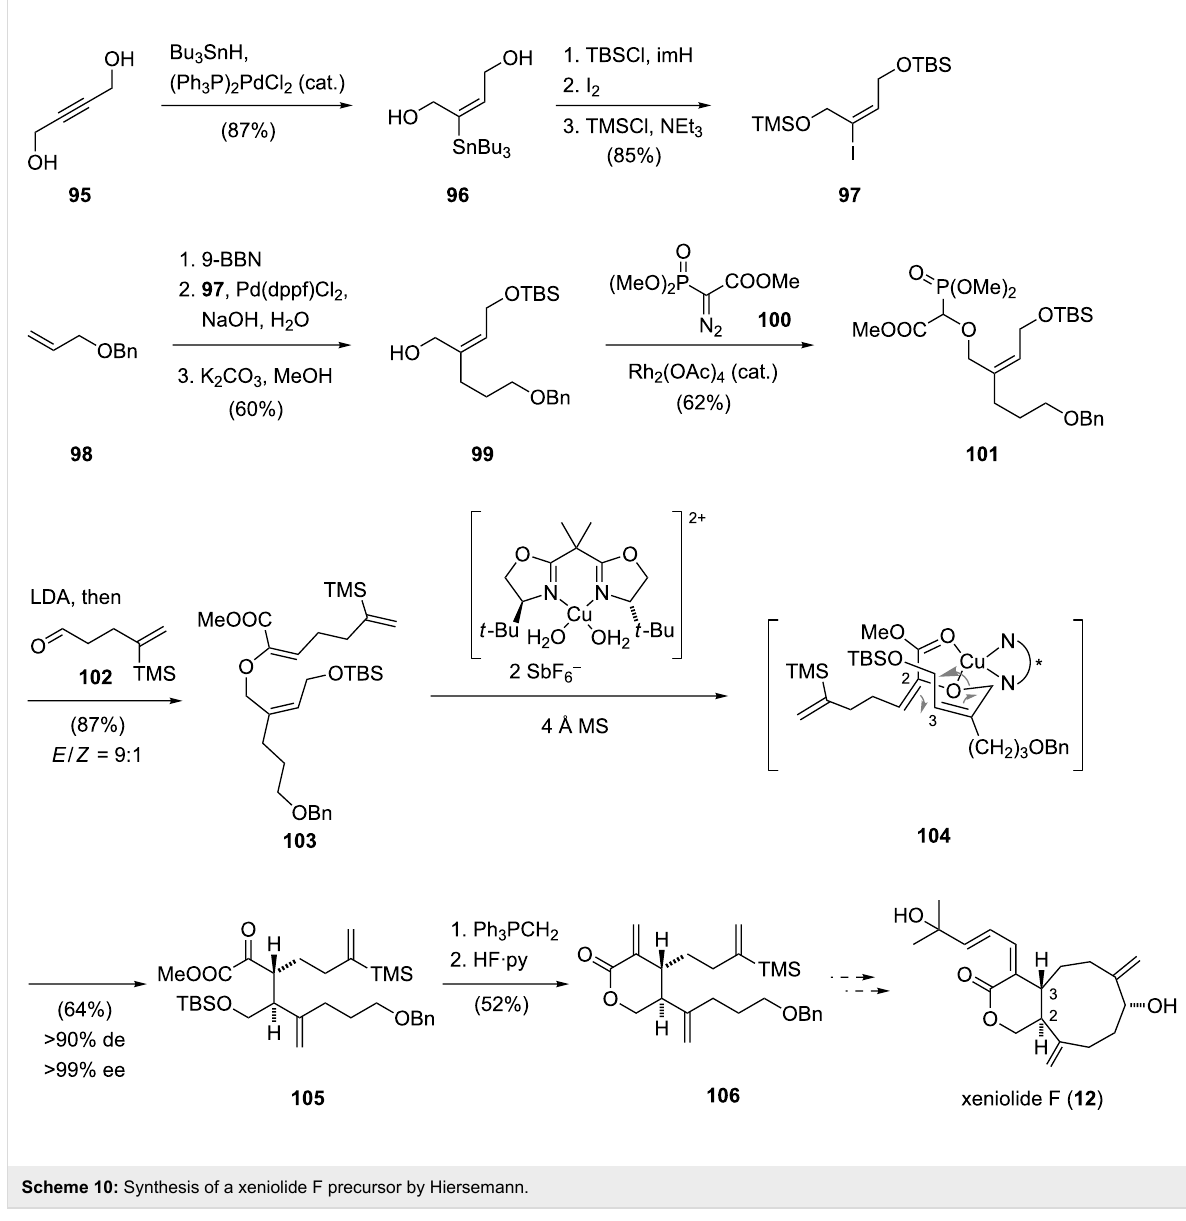
Scheme 10: Synthesis of a xeniolide F precursor by